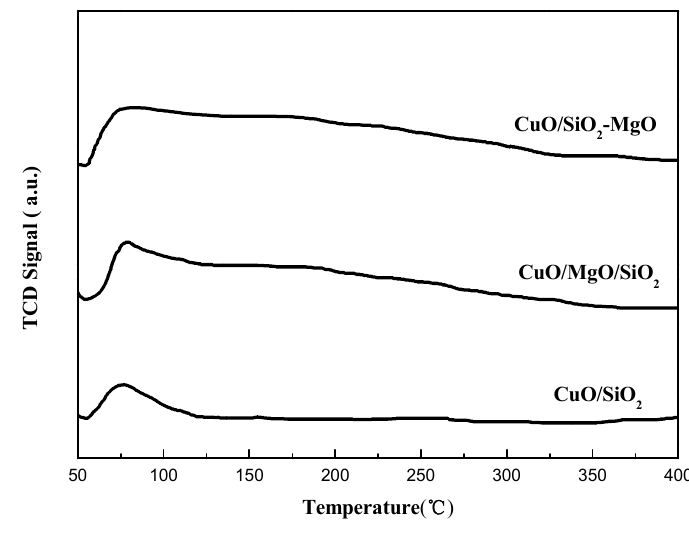
Figure 8. CO 2 -TPD of catalysts.